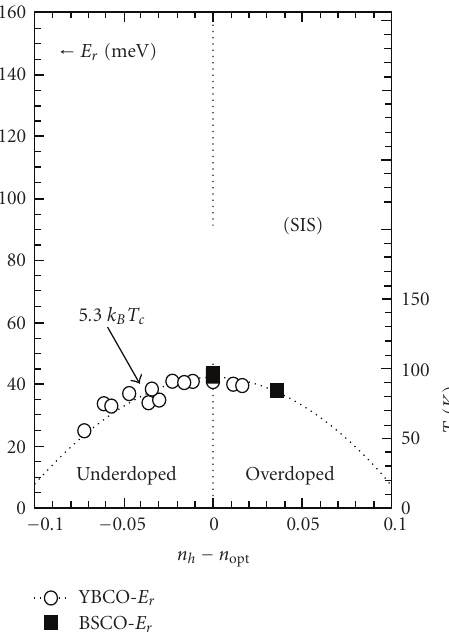
Figure 29: Doping dependence of the energy E r of the magnetic resonance peak at Q = ( π , π ) in YBCO and Bi 2212 measured at low temperatures by inelastic neutron scattering. From